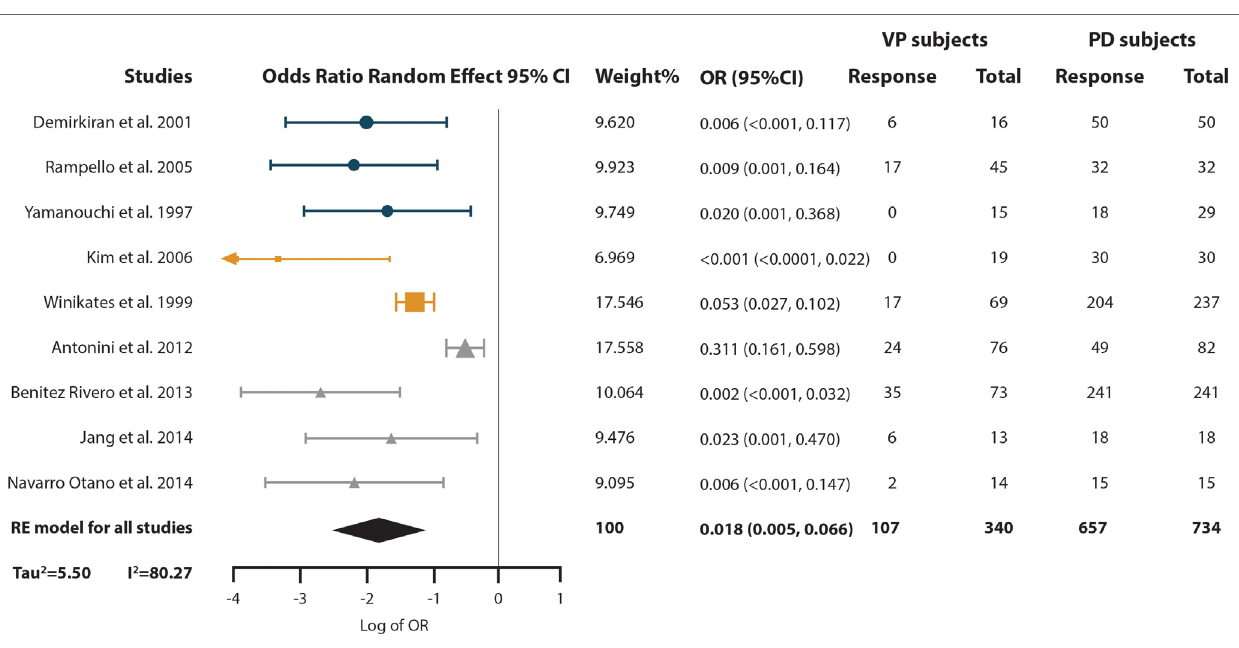
FigURe 5 | Pooled odds ratio (OR) and 95% confidence interval (CI) for the probability of vascular parkinsonism (VP) subjects responsiveness to levodopa compared with the probability of PD subjects response to it. Circles represent studies with the “Other” diagnostic criteria, squares represent studies with the “Winikates’” diagnostic criteria, and triangles represent “Zijlmans’ ” diagnostic criteria. Size of the geometrical figures is proportional to their respective relative weight. RE, random